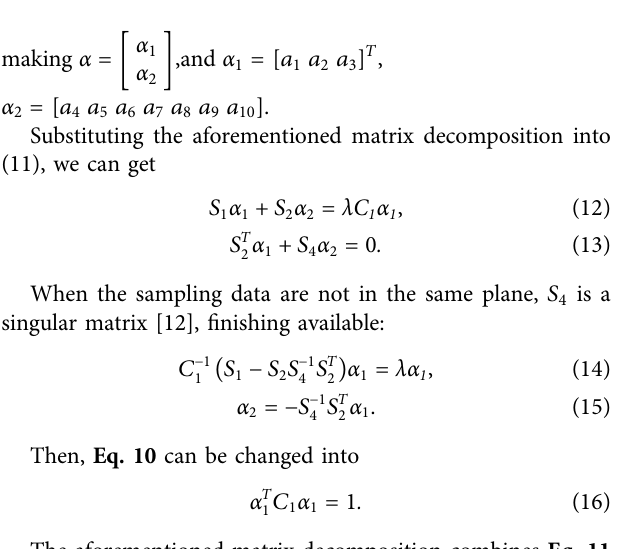
FIGURE 2 | Heading error of